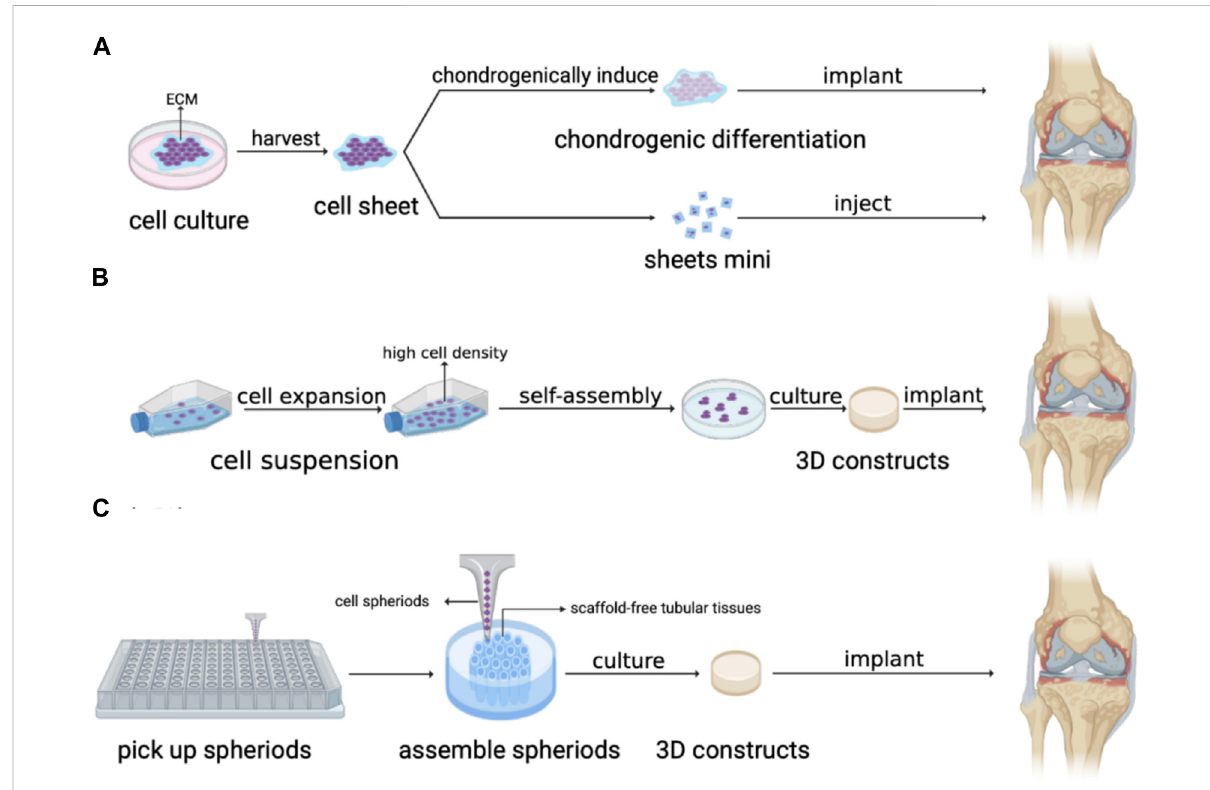
FIGURE 3 Application of arti fi cial AC without scaffold structure. (A) Cell sheet, (B) Self-assembly. and (C) 3D bioprinting by needle